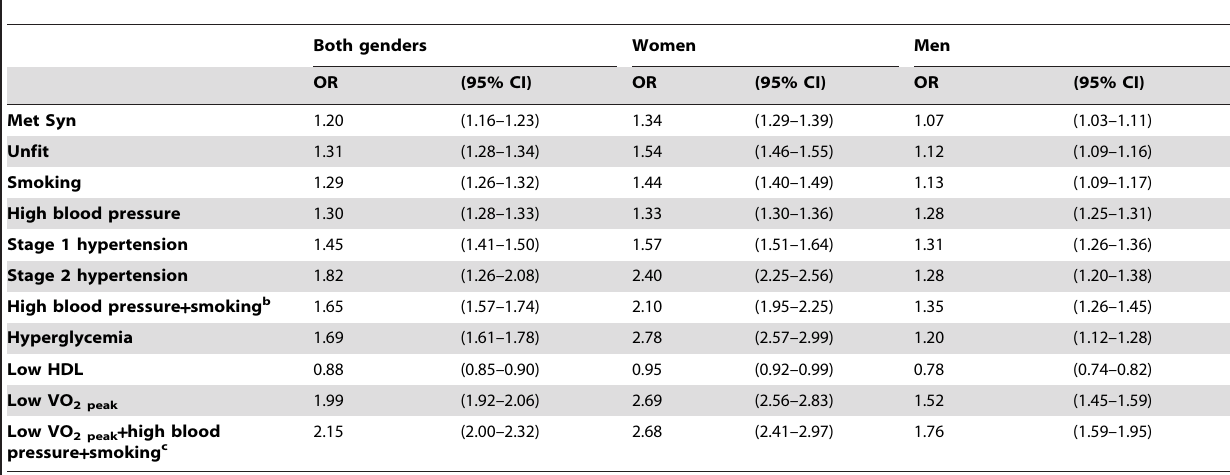
Table 3. Odds ratios for endothelial dysfunction, single predictors a